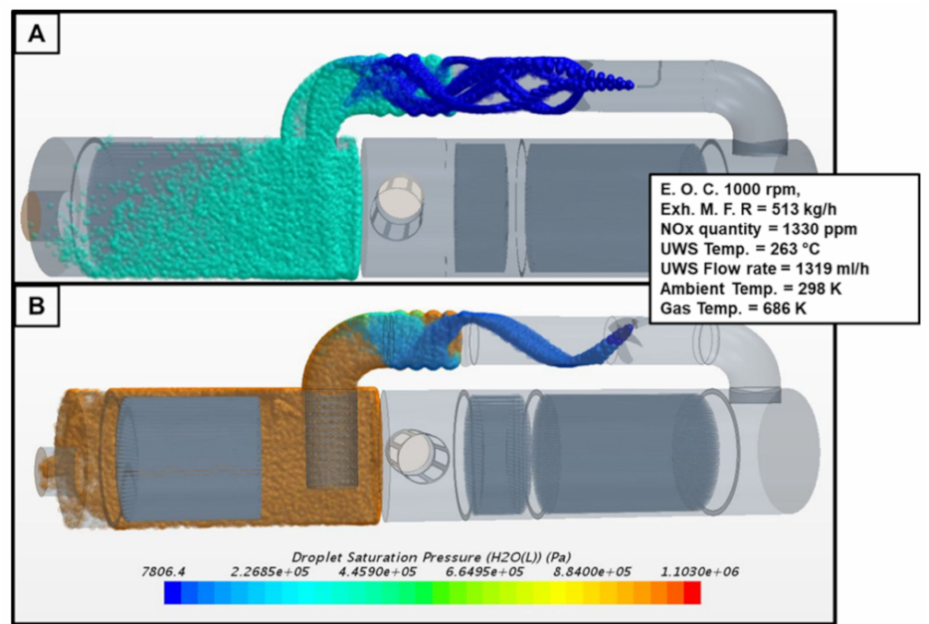
Figure 3. The urea saturation value: ( A ) original urea injector; ( B ) suggested urea injector for Hyundai